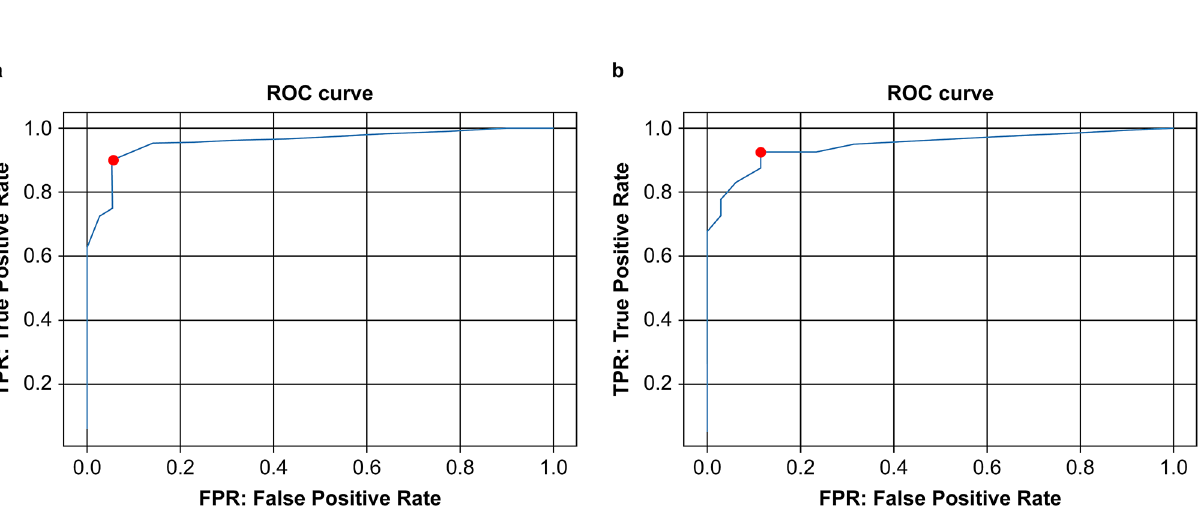
Table 2. The difference in the maximum diameter between enlarged extraocular muscle (EEM) and normal extraocular muscle (NEM). Unless otherwise indicated, the EEM and NEM data are expressed as means ± standard deviations. EEM enlarged extraocular muscle, IRM inferior rectus muscle, LRM lateral rectus muscle, MRM medial rectus muscle, NEM normal extraocular muscle, SRM superior rectus muscle.